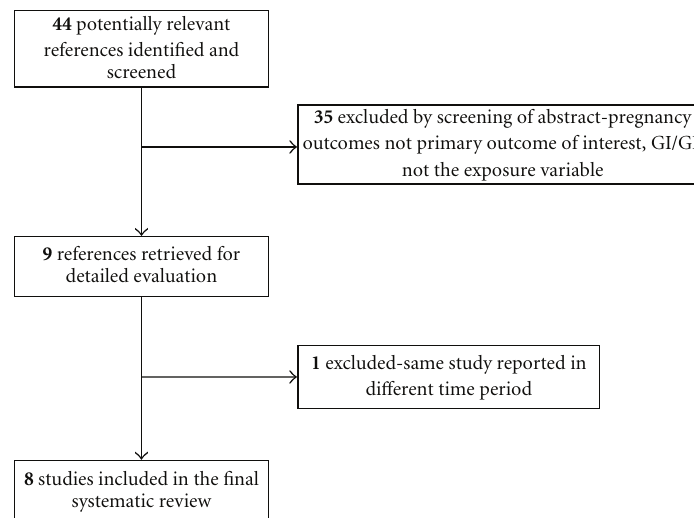
Figure 1: Papers identified through study selection